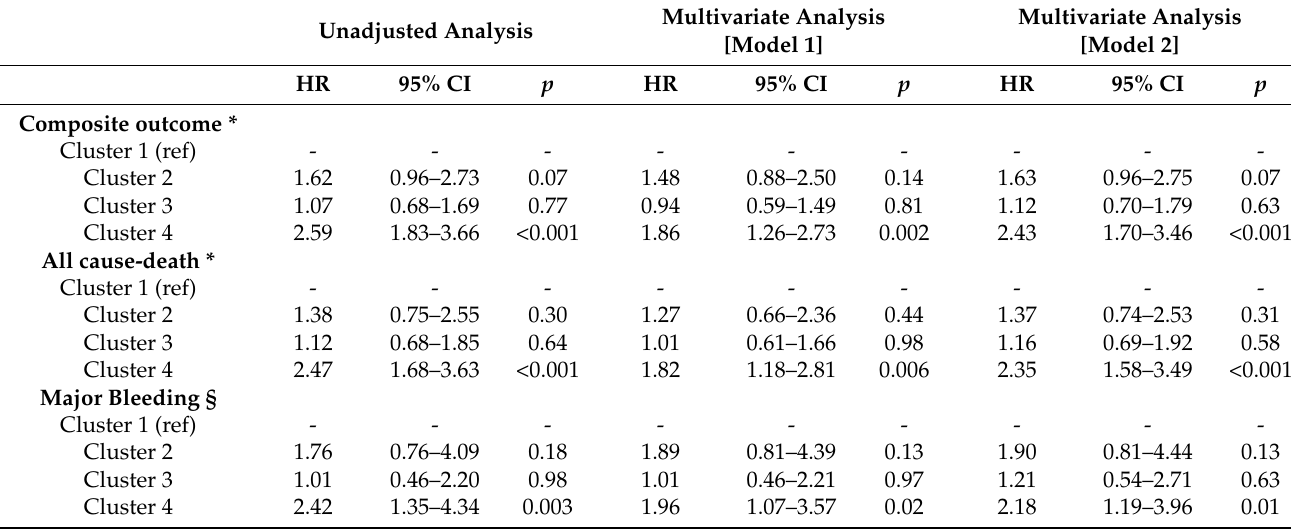
Table 3. Unadjusted and adjusted Cox regression analysis for all-cause death and the composite outcome. Multivariate Unadjusted Analysis